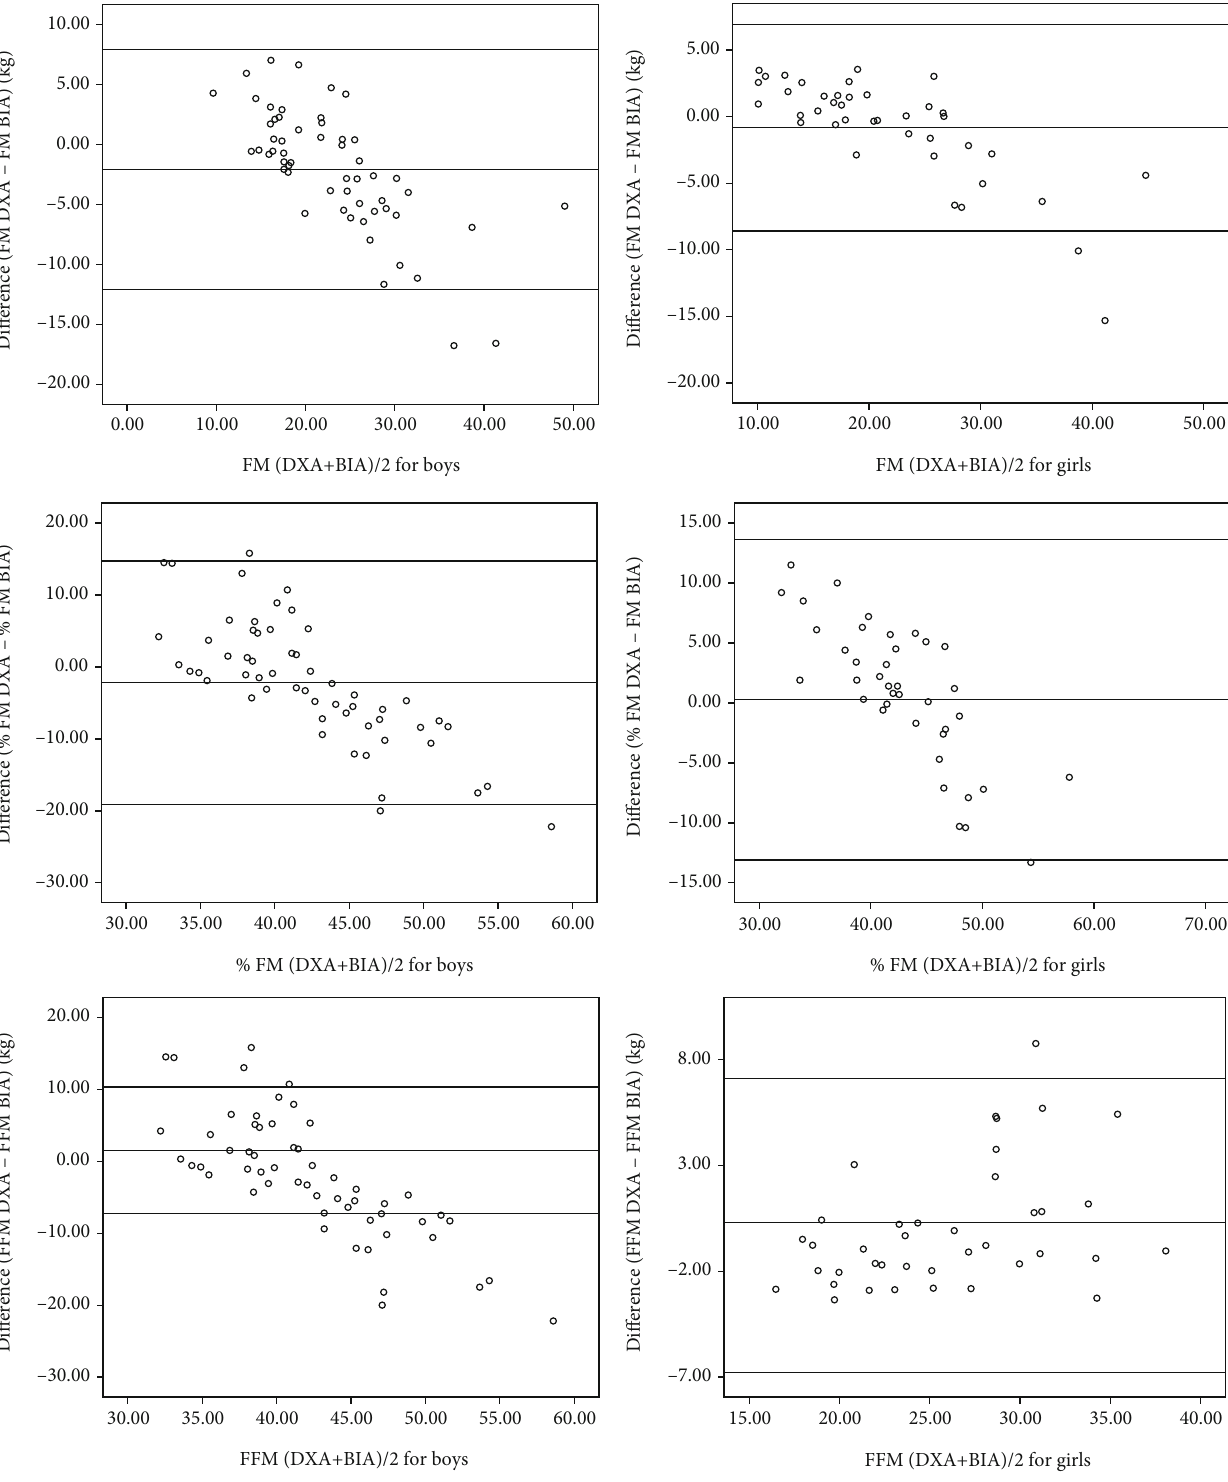
Figure 3: Bland-Altman plots comparing the accuracy of fat mass (FM), percentage fat mass (%FM), and fat-free mass (FFM) measurements by DXA and BIA in boys and girls. The middle line represents the mean di ff erence between DXA and BIA, and the upper and lower lines represent 95% limits of